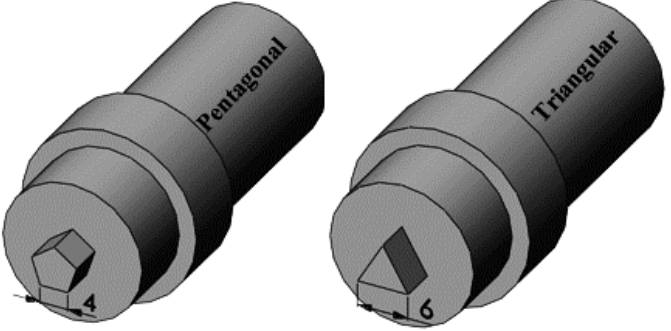
Figure 1. A sample for FSW experiment. Table 3. FSW process parameters and their levels.